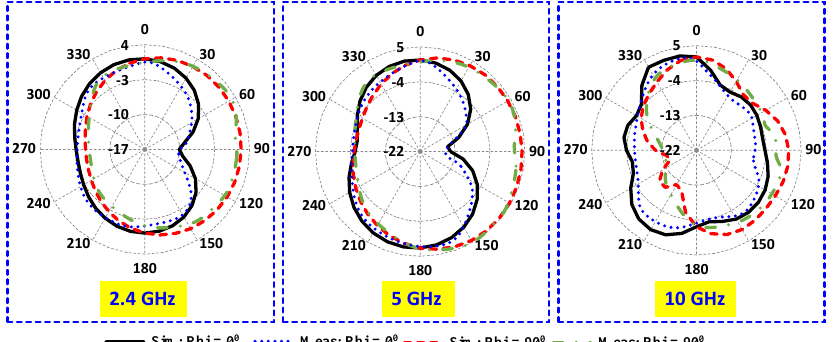
Figure 10. Simulated and measured peak gain of the antenna.